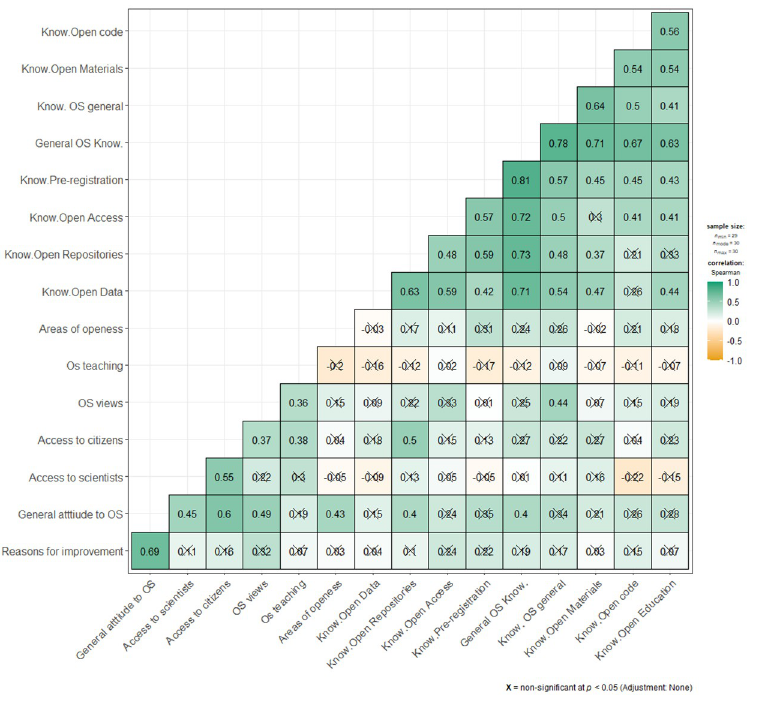
Fig 4. Correlations between items used to measure OS attitudes and knowledge.